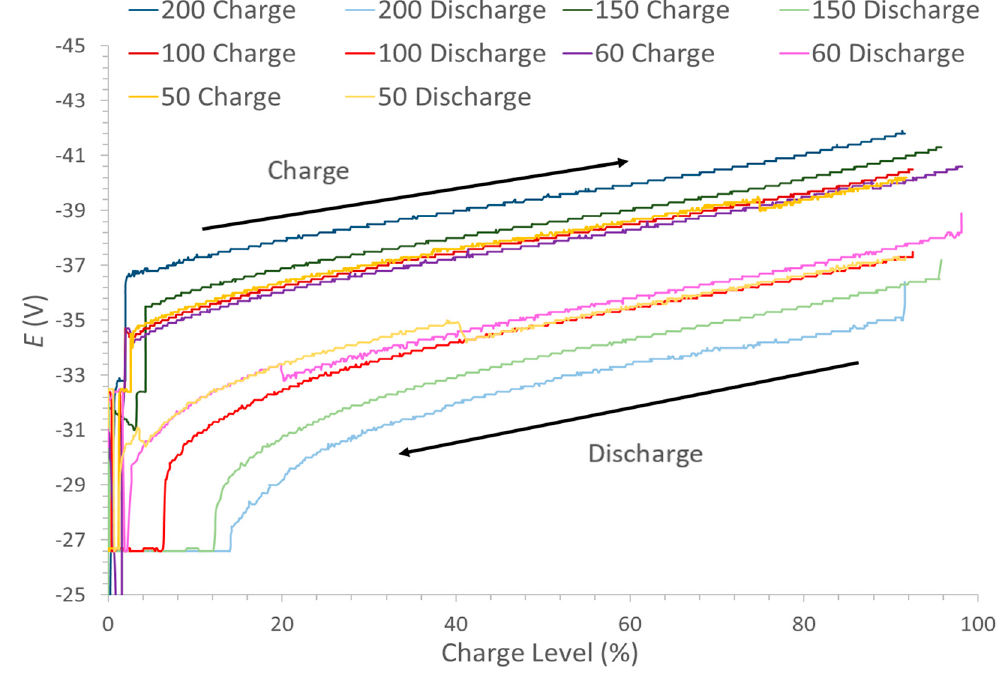
Figure 5. Voltage from one of the battery stacks at various constant power levels for charge and discharge.